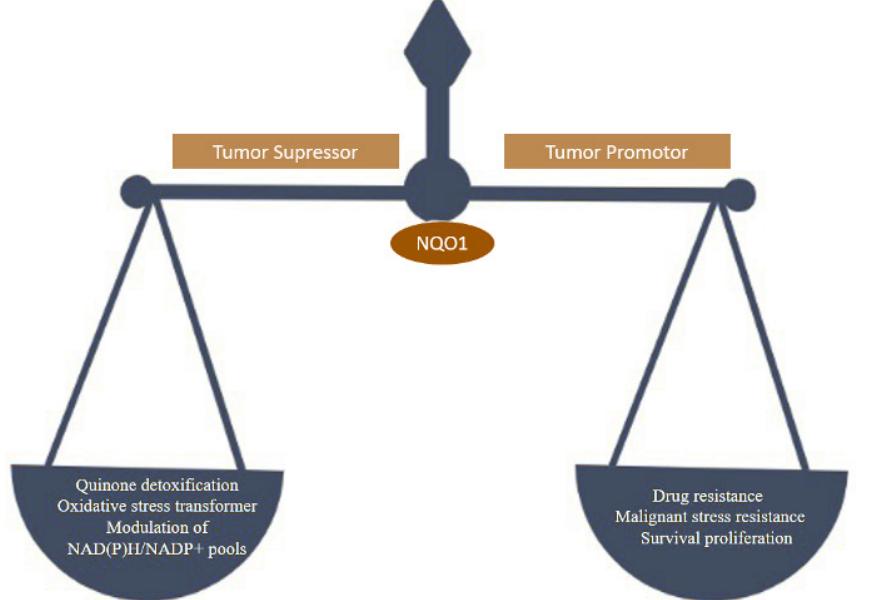
Figure 1. Tumor suppressor and tumor promoter behavior of NQO1 linked to reduced and increased oxidative stress